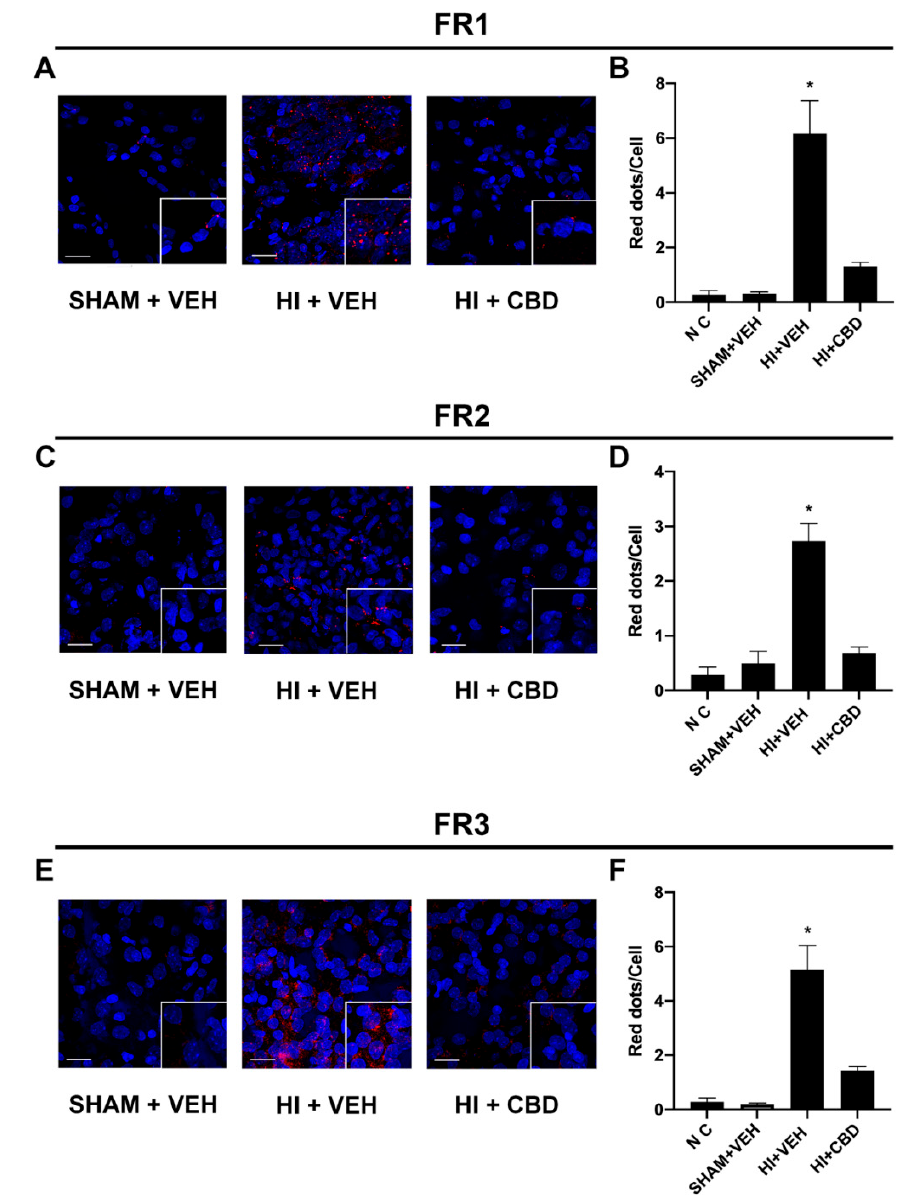
Figure 4. CB 2 -5HT 1A heteromer expression in brain slices from hypoxia-induced Wistar rats. ( A , C , E ) CB 2 –5HT 1A -Hets expression in brain slices from hypoxia-induced Wistar rats (HI + VEH), hypoxia-induced Wistar rats treated with CBD (HI + CBD), and control Wistar rats (SHAM + VEH), detected by PLA. Rat brains were dissected 1 (FR3), 7 (FR2), or 30 (FR1) days after the insult, as described in the Materials and Methods. Red dots indicate expression of heteromers. Hoechst-stained nuclei appear in blue. ( B , D , F ) Quantification of the CB 2 –5HT 1A Hets was conducted by detecting the number of red dots/cell using the Andy’s algorithm Fiji’s plug-in. Samples from 6 different animals were processed and analyzed. The NC negative control bar in panels B, D, and F refers to counts in cells treated only with secondary antibodies. Scale bar: 20 µ m. * p < 0.05 versus SHAM+VEH.